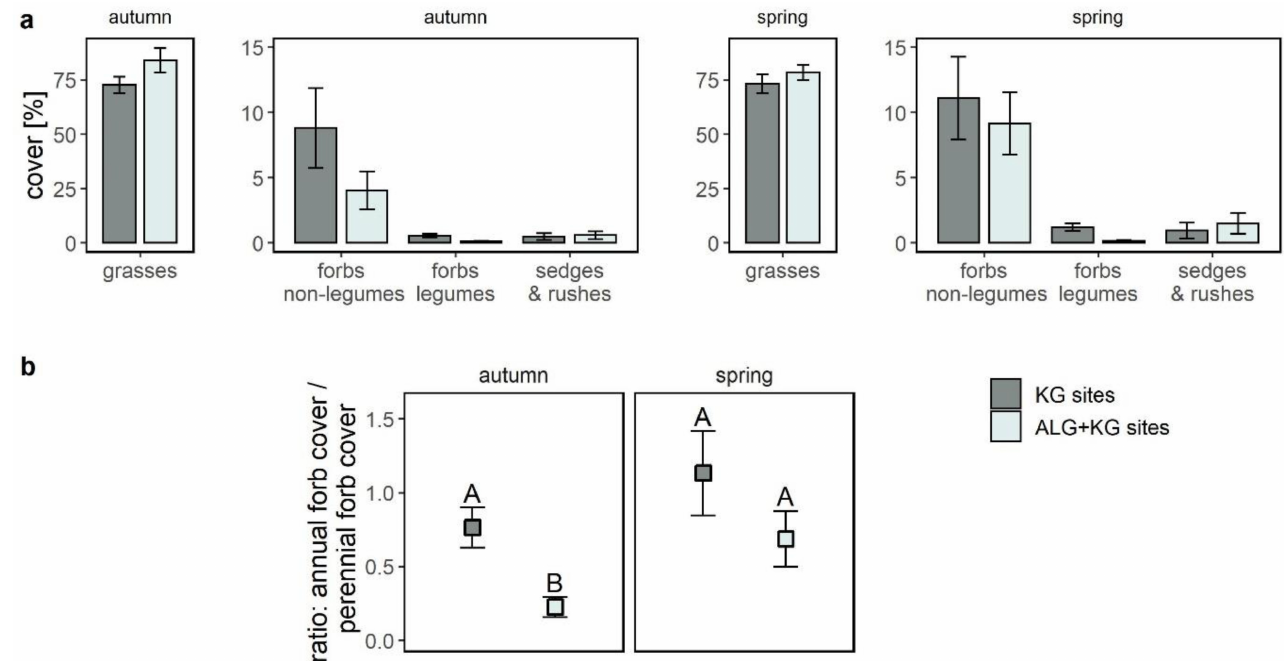
Figure 3. ( a ) Composition of functional groups for KG (darker colour) and ALG+KG (lighter colour) sites in autumn and spring with the mean cover per functional group for each plot including the standard error as error bars. ( b ) The mean ratio of annual forb cover to perennial forb cover per plot is given for each site type with the standard error as bars. Different capital letters indicate significant differences ( p -value < 0.05) among site